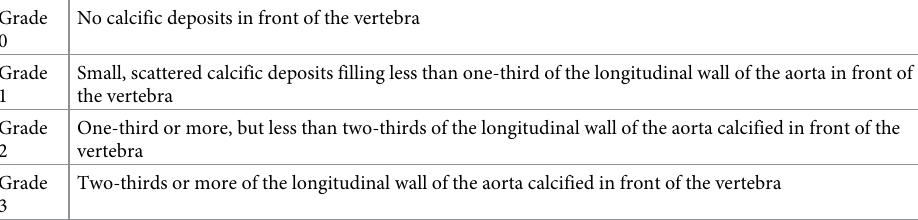
Table 1. Classification of abdominal aortic calcification by Kauppila et al.[10].